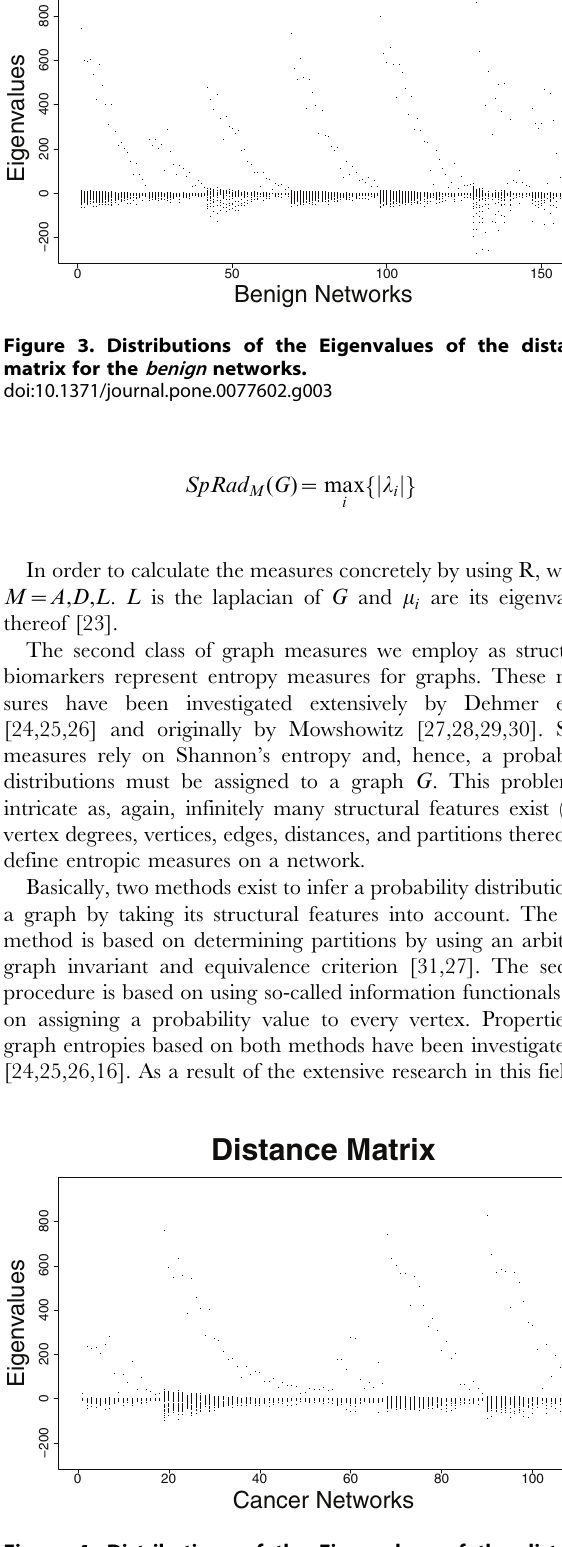
Figure 4. Distributions of the Eigenvalues of the distance matrix for the cancer